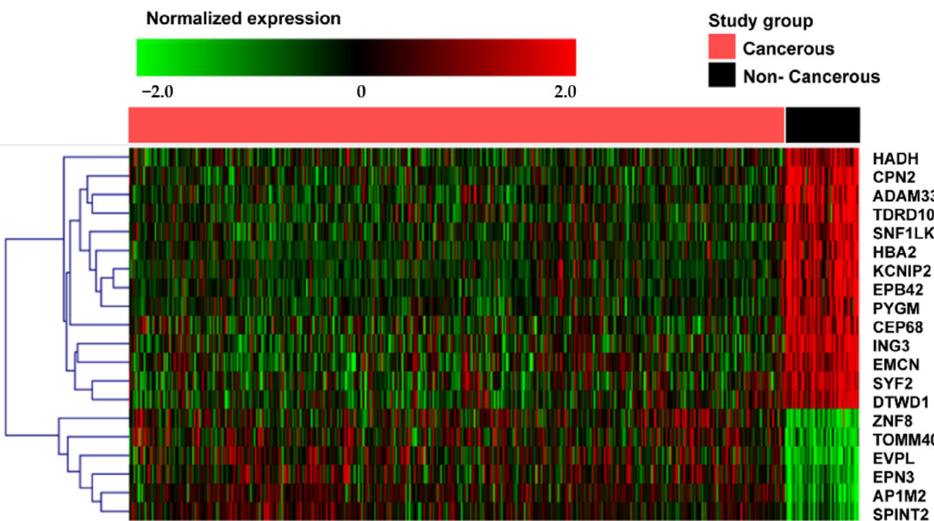
Figure 2. Heatmap of selected 20 mRNAs from cancerous and non-cancerous tissues. Heatmap is obtained using bidirectional hierarchical clustering of 20 significantly expressed mRNAs ( p < 0.05 by Pearson correlation, hierarchical clustering analysis). Red dots indicate upregulated mRNAs and green dots indicate downregulated mRNAs.